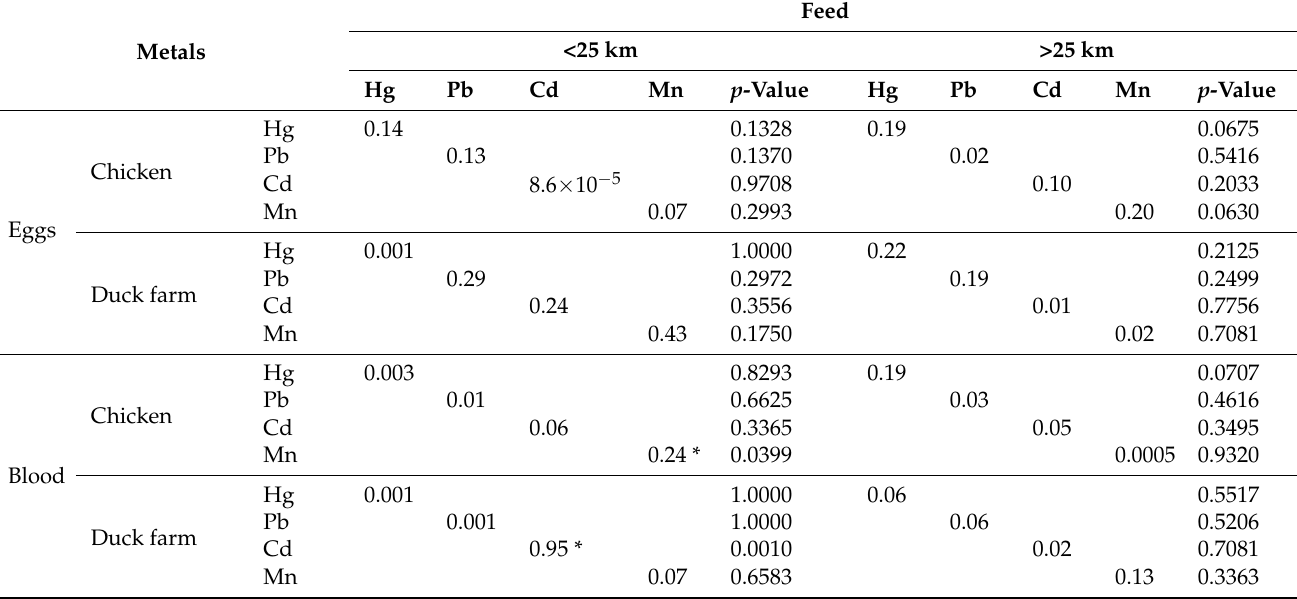
Table 8. Correlations between THg, Pb, Cd, and Mn in eggs, blood, and feed (r 2